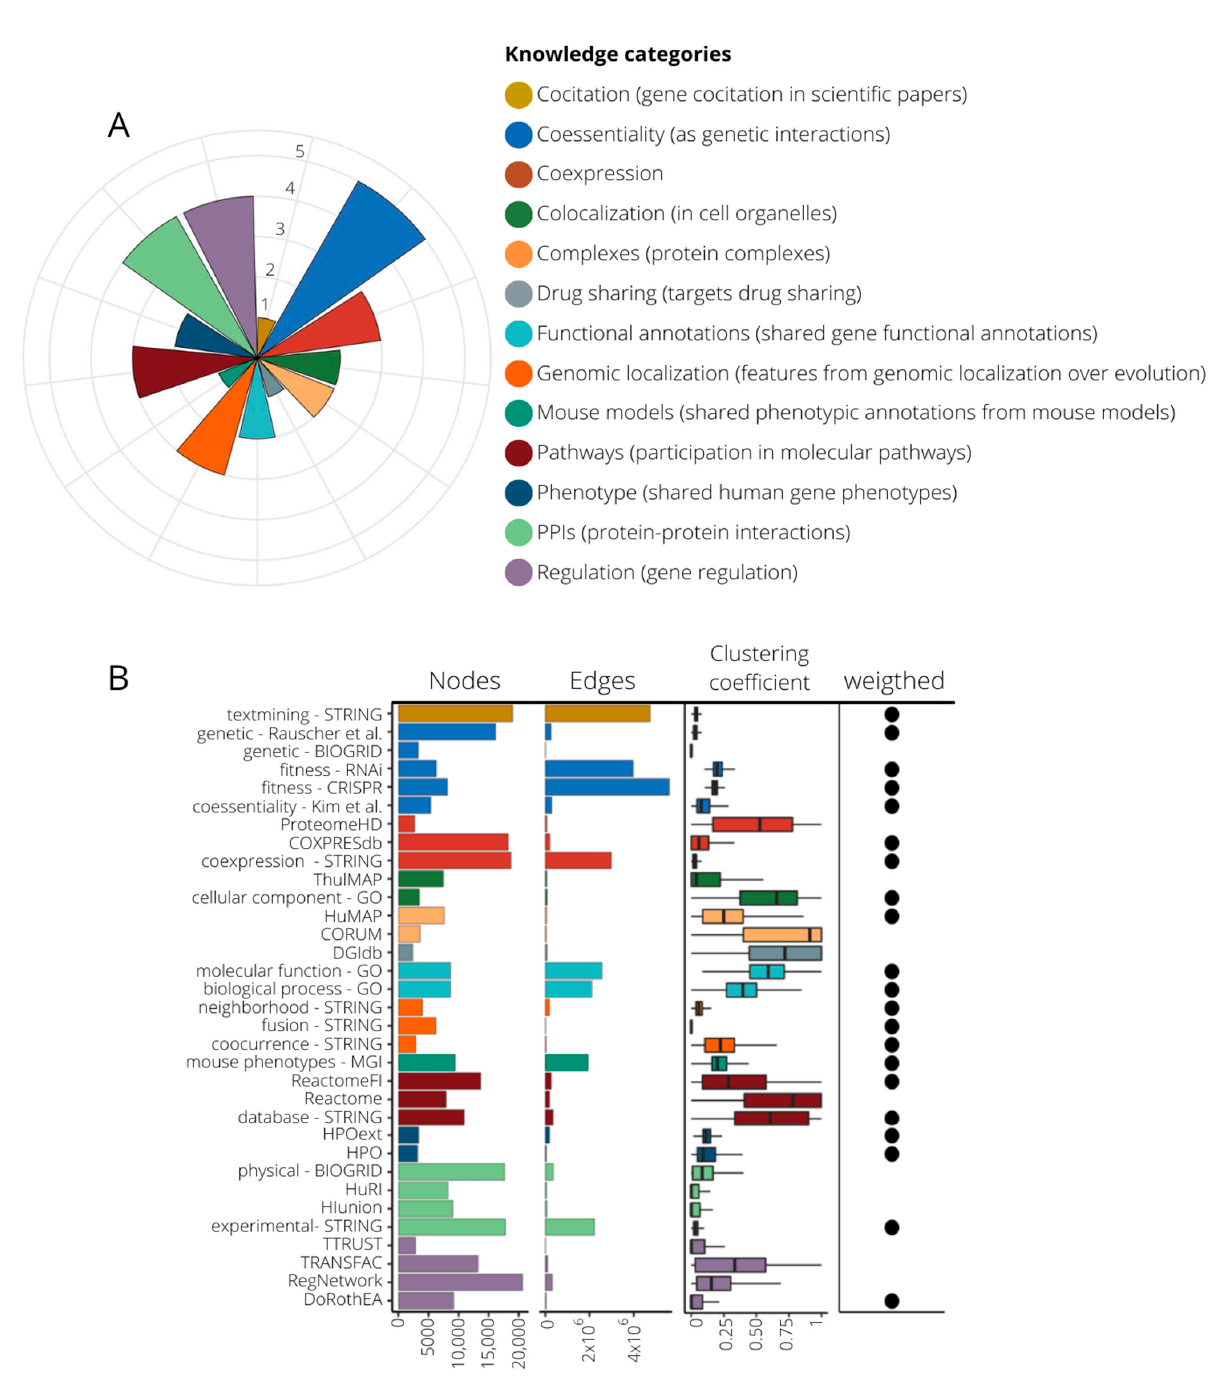
Figure 1. Composition of knowledge categories (KCs) and their network properties. ( A ) 13 KCs grouping 33 datasets. The pie chart indicates the number of source contributors per KC, ranging from one (drug sharing, co-citation, and mouse models) to five (co-essentiality). ( B ) Network attributes of the 33 networks generated from the compiled datasets. Here we present number of nodes, number of edges, the mean of their clustering coefficient, and whether edges are weighted or not. Color code is assigned according to their